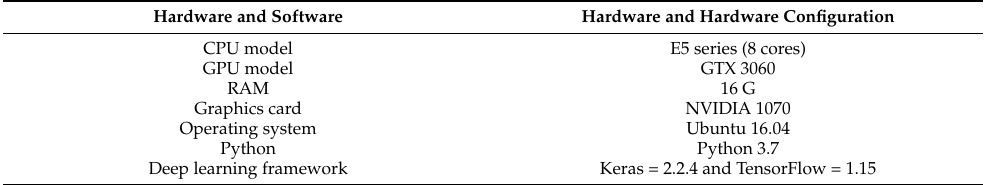
Table 1. Experimental software and hardware environments.